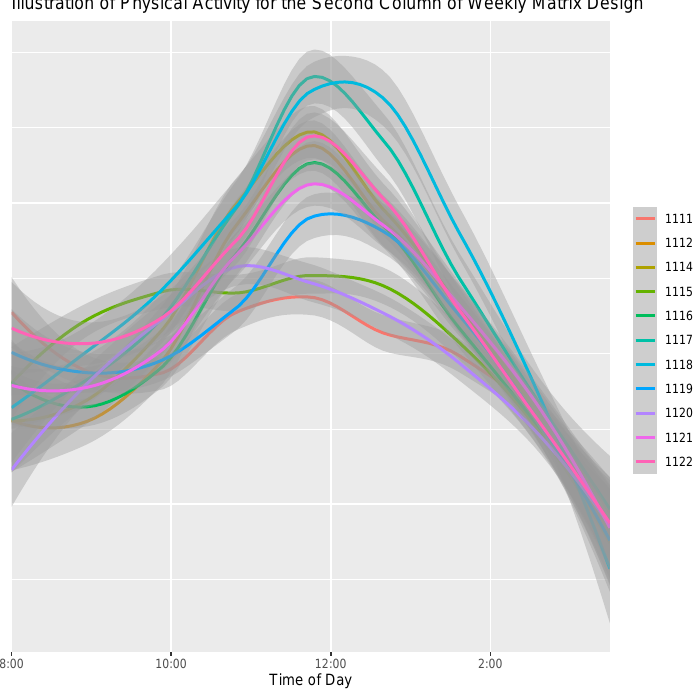
Figure 6. Second column of weekly activity for 11 subjects over five